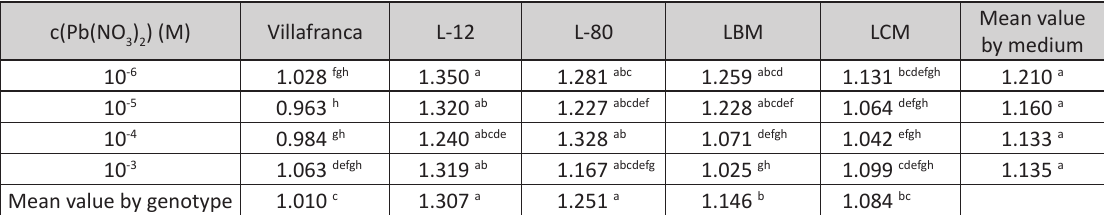
Tolerance index for shoot height of white poplar on examined lead concentration in medium (LSD test) c(Pb(NO ) ) 3 2